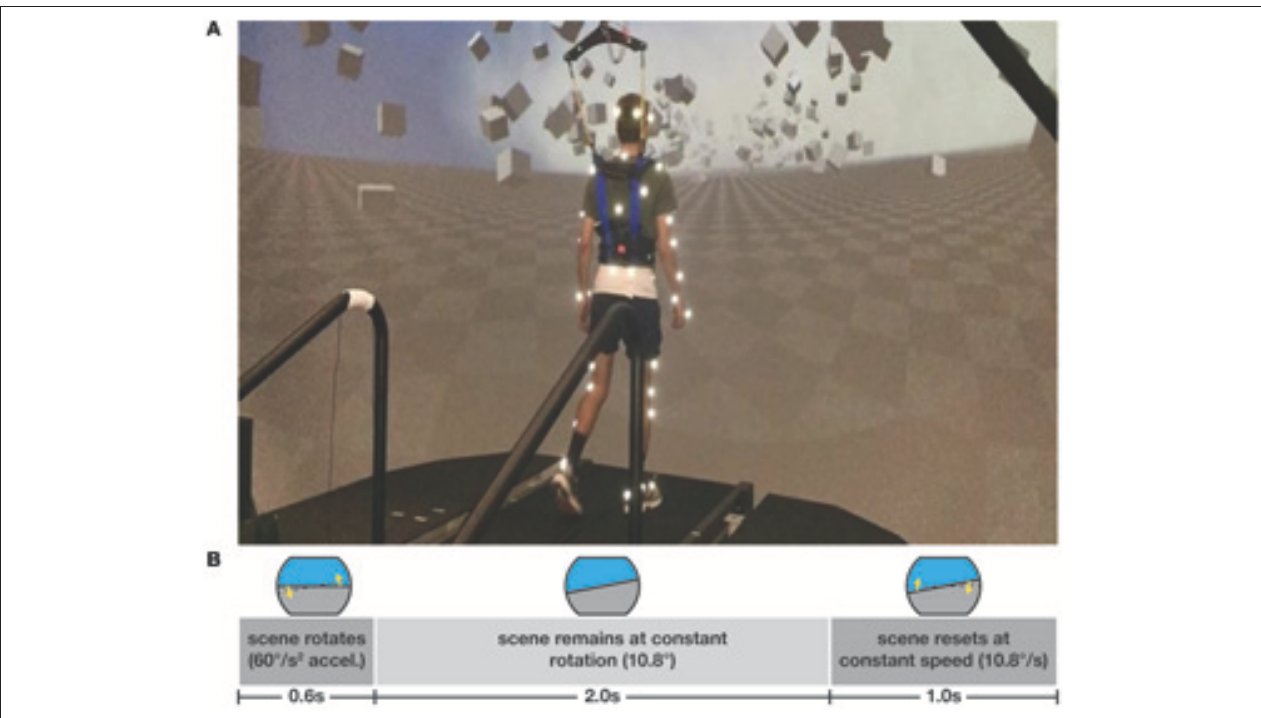
FIGURE 1 | Experimental setup (A) and stimulus pattern (B) . Subjects walked on a treadmill in the virtual reality environment. Triggered on heelstrike, the environment rotates for 0.6s, then remains static for 2 s before resetting with uniform speed over 1 s.